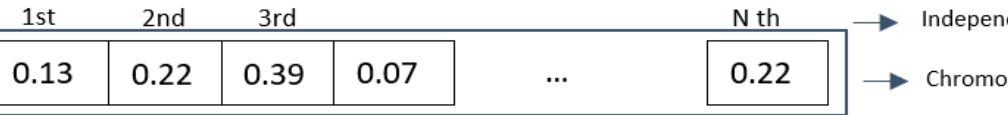
Figure 3. GA Chromosome Representation.